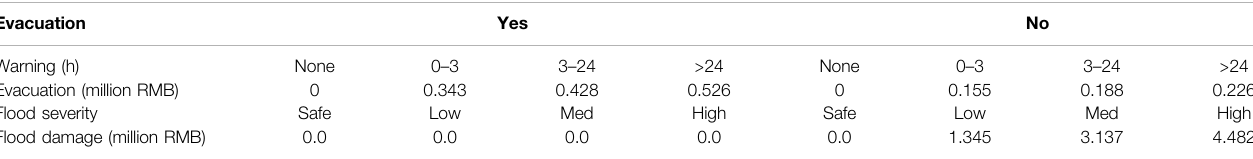
TABLE 3 | Prior probability of evacuation cost and fl ood damage with P ar of 1,000 based on Peng and Zhang (2013a). Evacuation Yes Warning